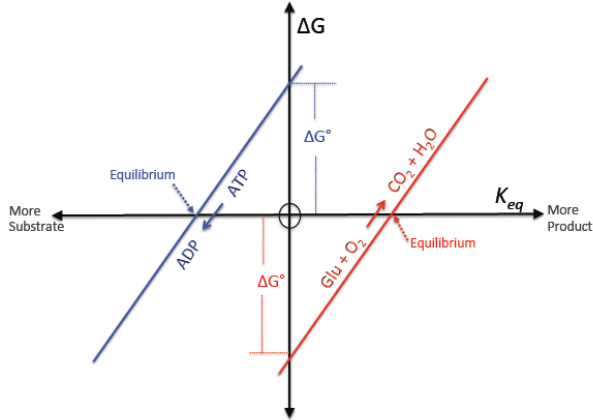
Fig. 1. A schematic illustrating the relationship between the free energy change ( 1G ), the free energy change under standard con- ditions ( 1G ◦ ), and the equilibrium constant ( K eq ) . At equilibrium ( 1G = 0), the glucose (Glu) oxidation reaction (red line) is shifted far to the right, resulting in a high K eq (10 503 , ratio of product, CO 2 , to reactant, O 2 ) . 1G ◦ for glucose oxidation is very large and neg- ative ( − 689kcalmol − 1 ) meaning that, under standard conditions ( K eq = 1), the reaction is highly favored in the forward direction. The energy derived from this highly exergonic reaction is used to drive the synthesis of ATP (blue line), a highly endergonic and un- favorable